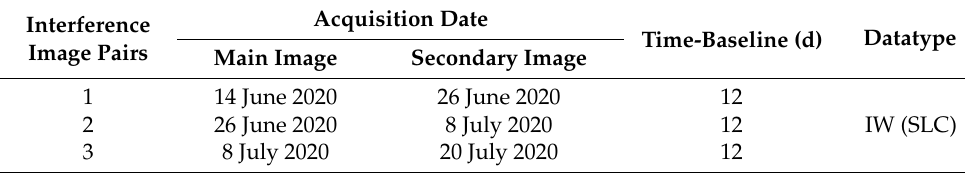
Table 1. Data information of Sentinel-1A for the study area.